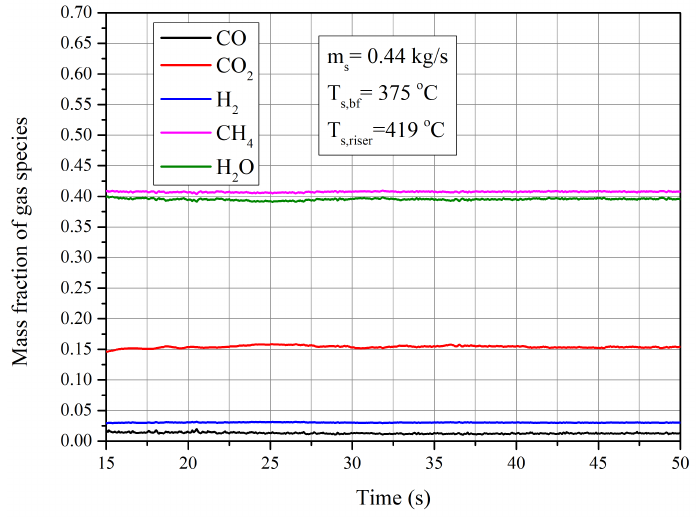
Figure 18. Profile of time-averaged gas species mass fraction with mass flow rate 0.44 kg/s. Temper- ature of bulling fluidized bed is 375 ◦ C. N 2 is used as balance gas.